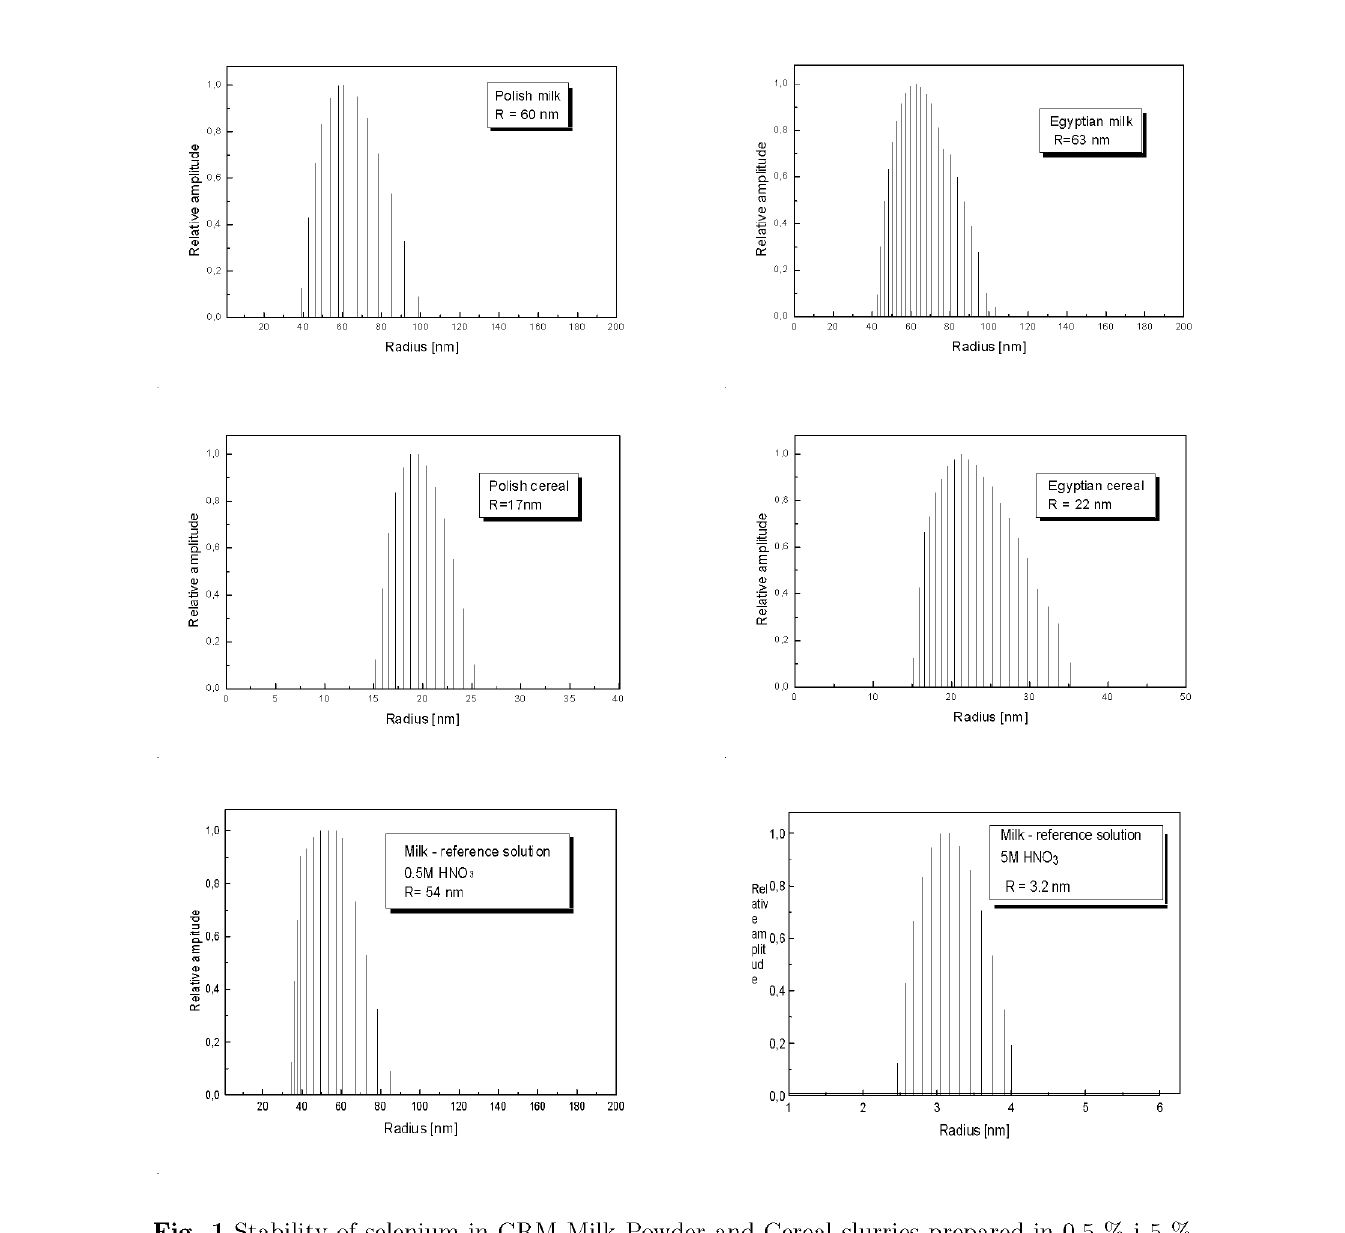
Fig. i Stability of selenium in CRM Milk Powder and Cereal slurries prepared in 0.5 % i 5 % nitric acid with 0.1% Triton X - 100. The slurry samples were agitated with ultrasonic probe only before injection of the first